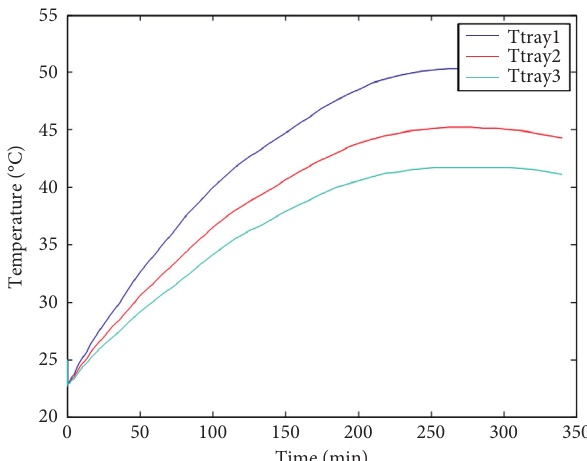
Figure 12: Experiment temperature profiles in the dryer chamber.